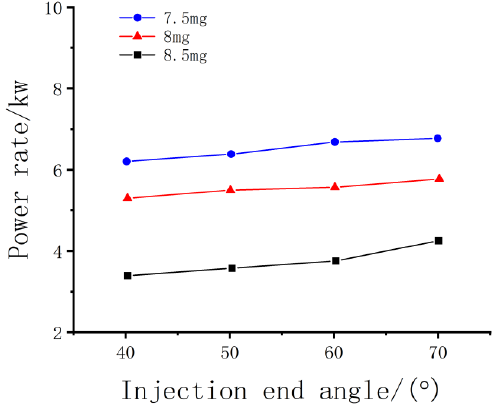
Figure 31. Effect of the injection parameters on engine power.